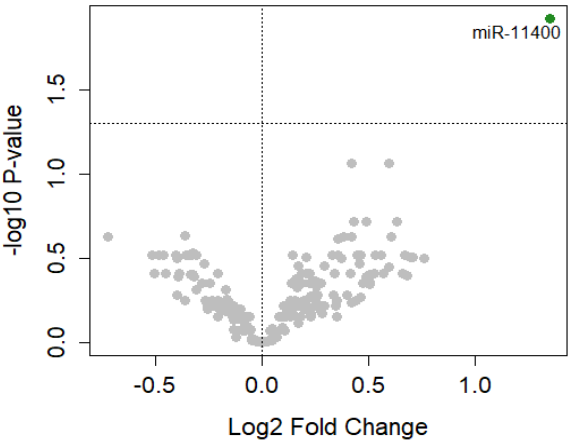
Figure 1. Volcano plot of differentially expressed miRNAs. Each dot represents a miRNA. The green dot represents miR-11400 significantly differentially expressed at FDR ≤ 0.05. The gray dots represent miRNAs that were not significantly differentially expressed at FDR.